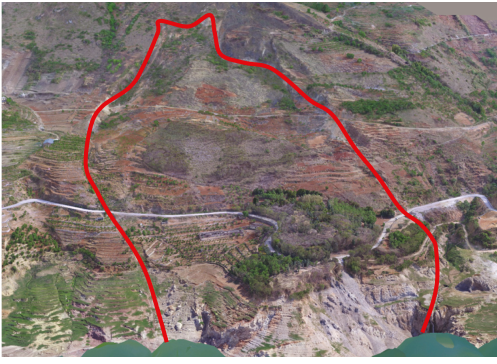
Figure 2: 3D view of the Hongyanzi